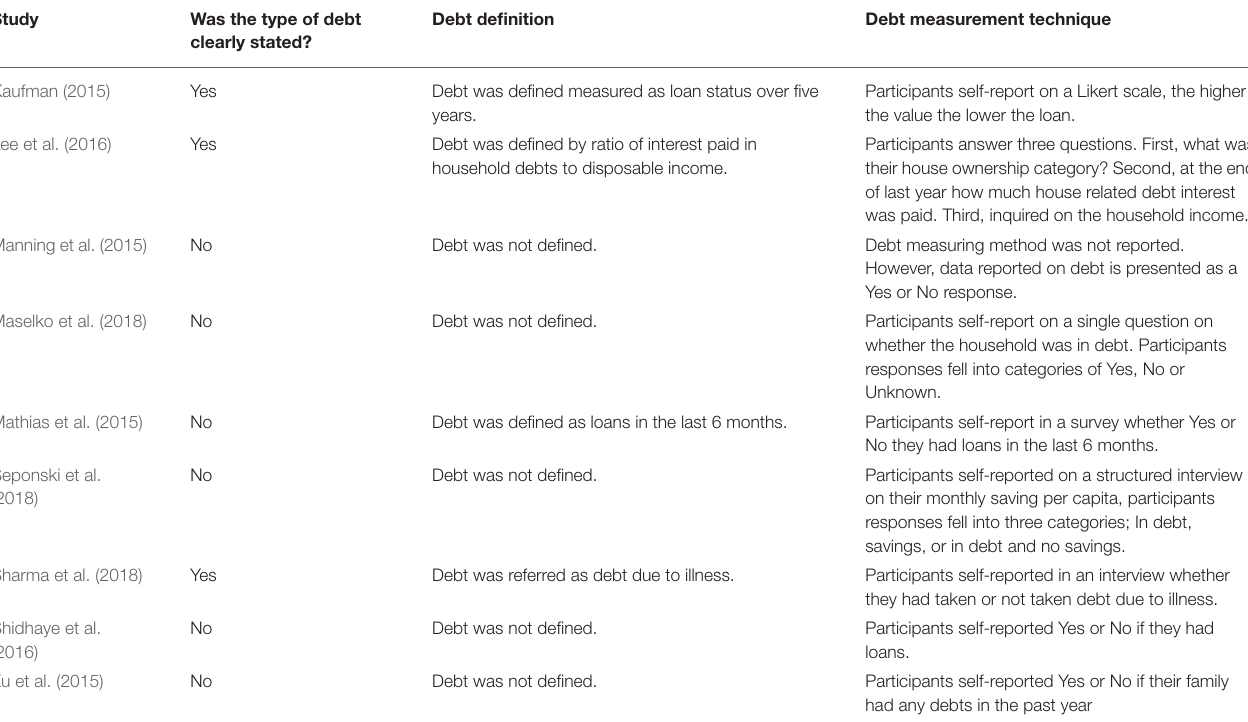
TABLE 3 | The types, definitions and measurement of debts.